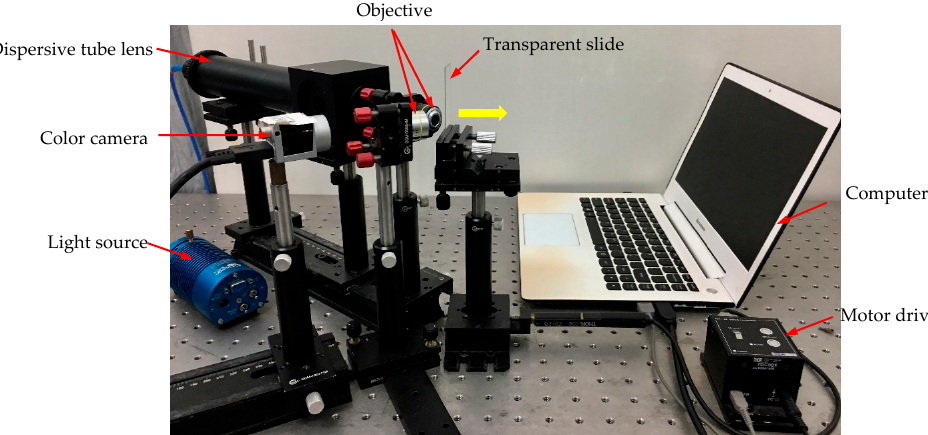
Table 1. The parameters of the objectives.